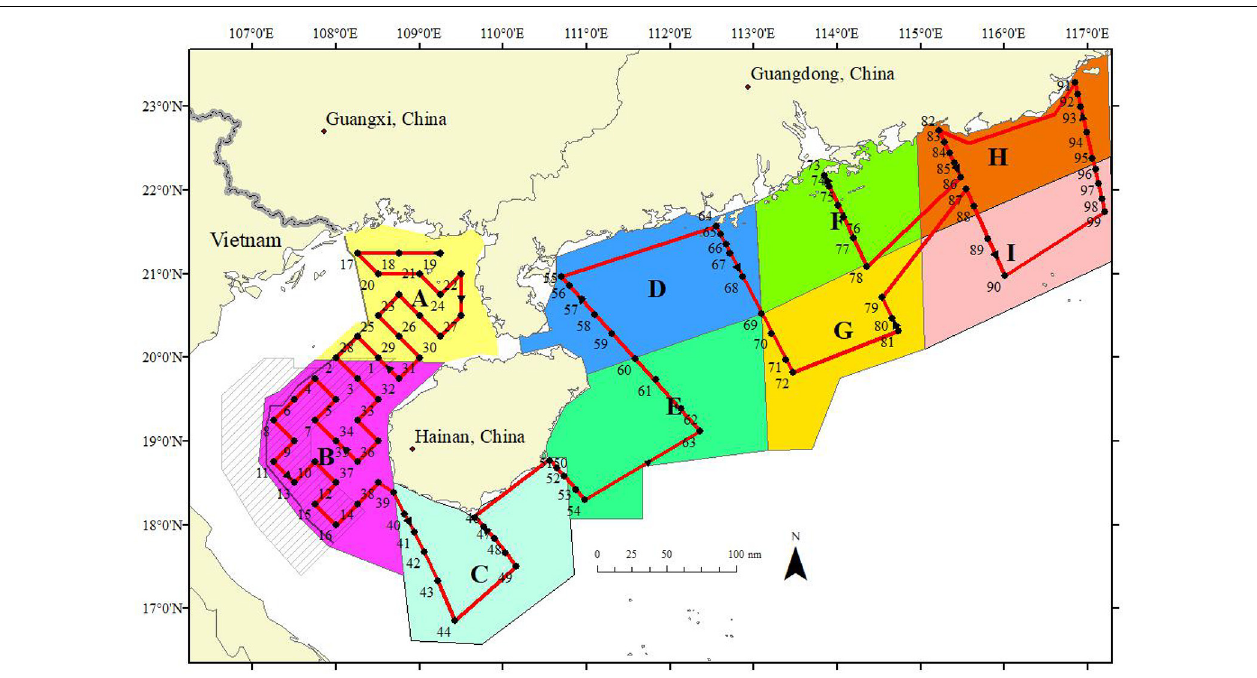
FIGURE 1 | Acoustic navigation route (red lines) and sampling sites (black points) employed during the fishery. The letters A–I represent each partition (Map created in ArcGIS Desktop 9.3.